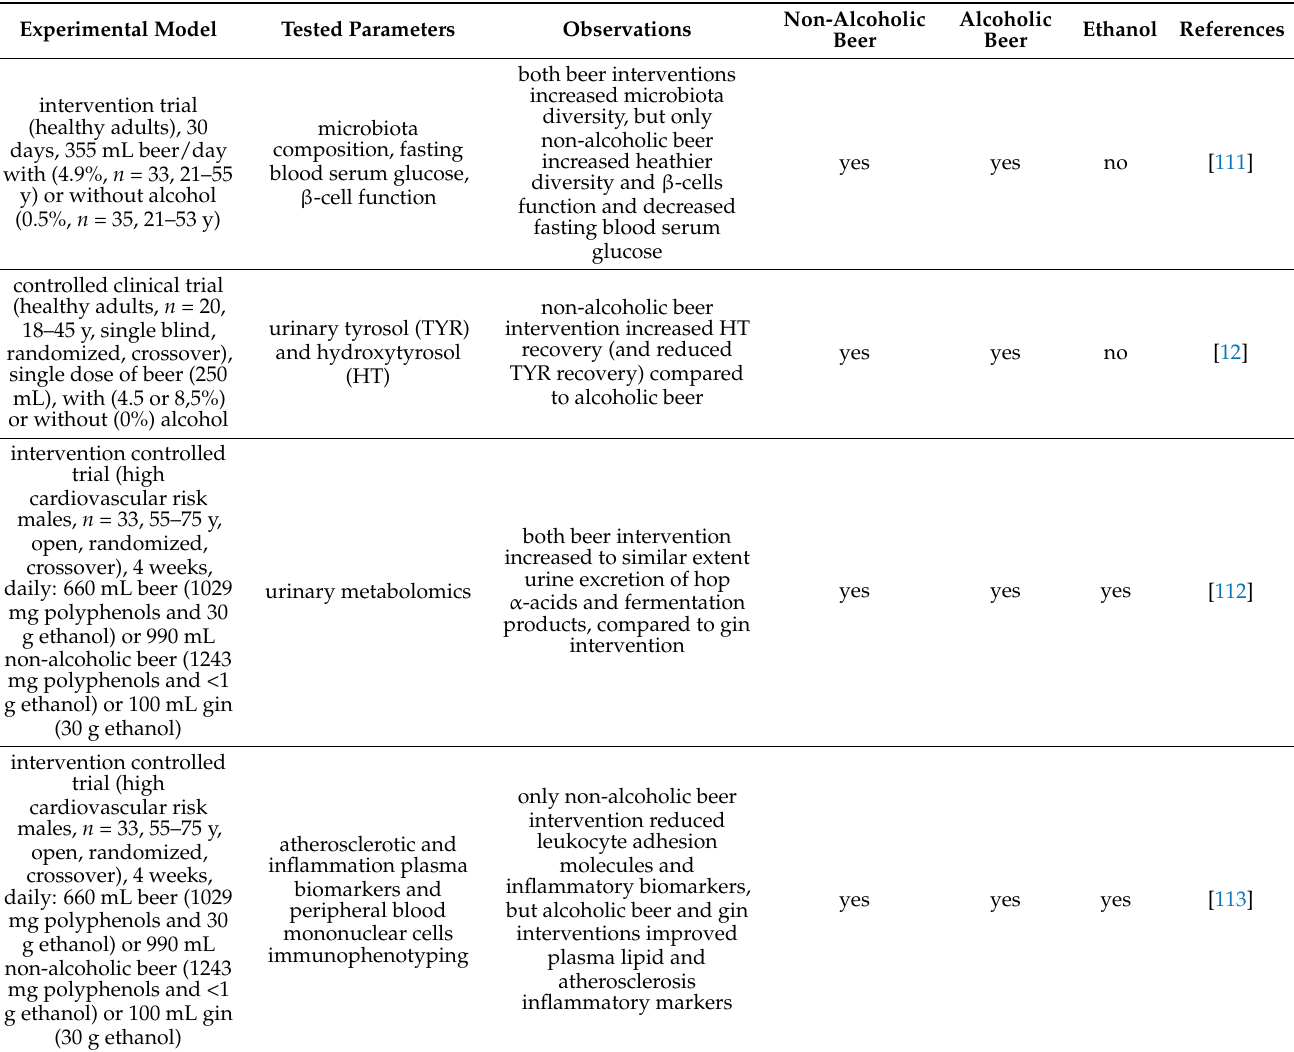
Table 2. Intervention studies ( n , subjects’ number; y, age